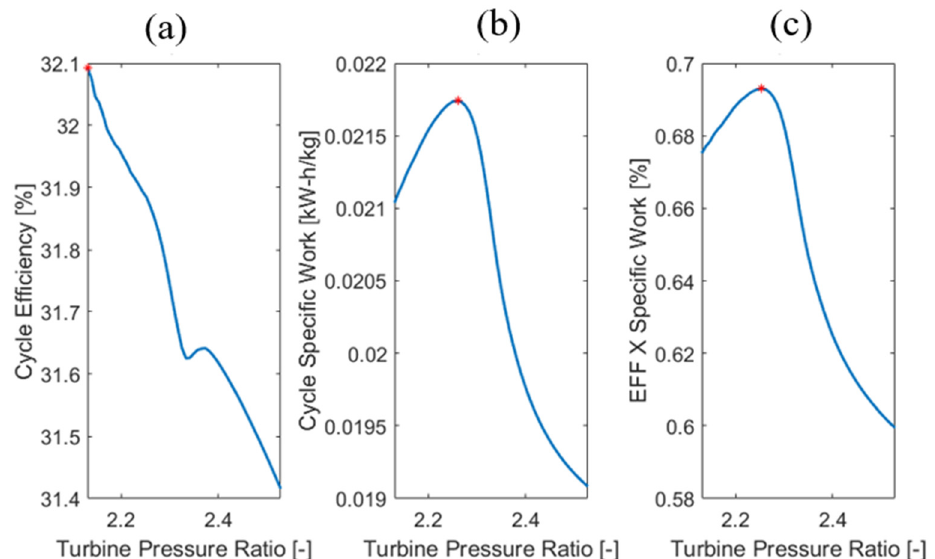
Figure 21. ( a ) Cycle Efficiency, ( b ) Cycle Specific Work, and ( c ) the mix mode along the turbine pressure ratio of S-CO 2 Brayton cycle.